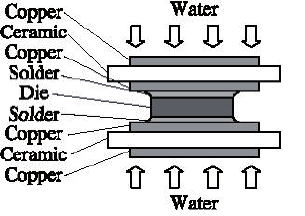
Fig. 8. Direct solder contact module [8]. Table 1. Base plates constitutive laws parameters [4,12].